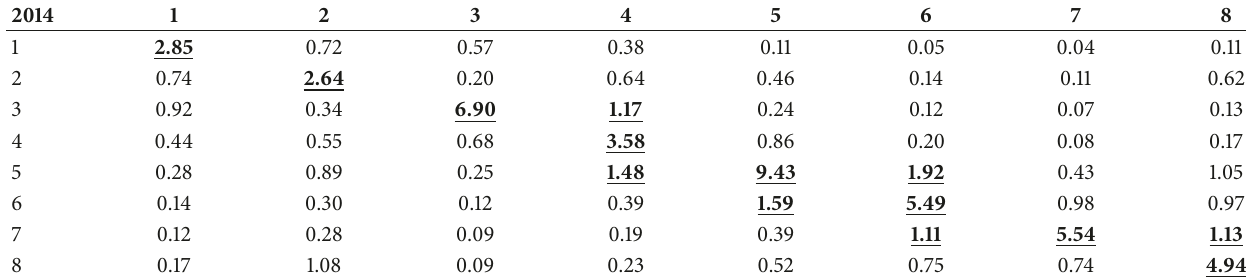
Table 8: Subgroup density table of the HRB urban network in